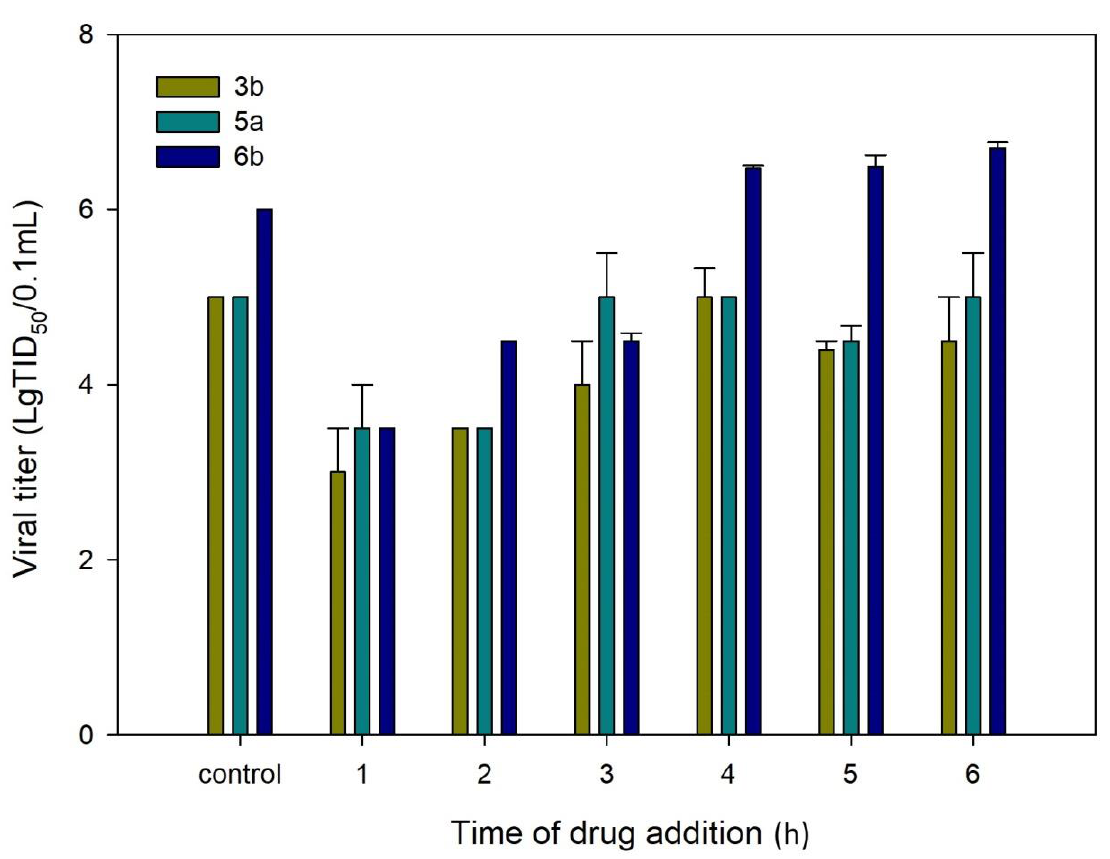
Figure 1. Time-of-addition assay. HEp-2 cells were infected with the RSV A strain and compounds 3b , 5a , and 6b were added for different time periods after infection. Wells to which no compound was added were used as controls.